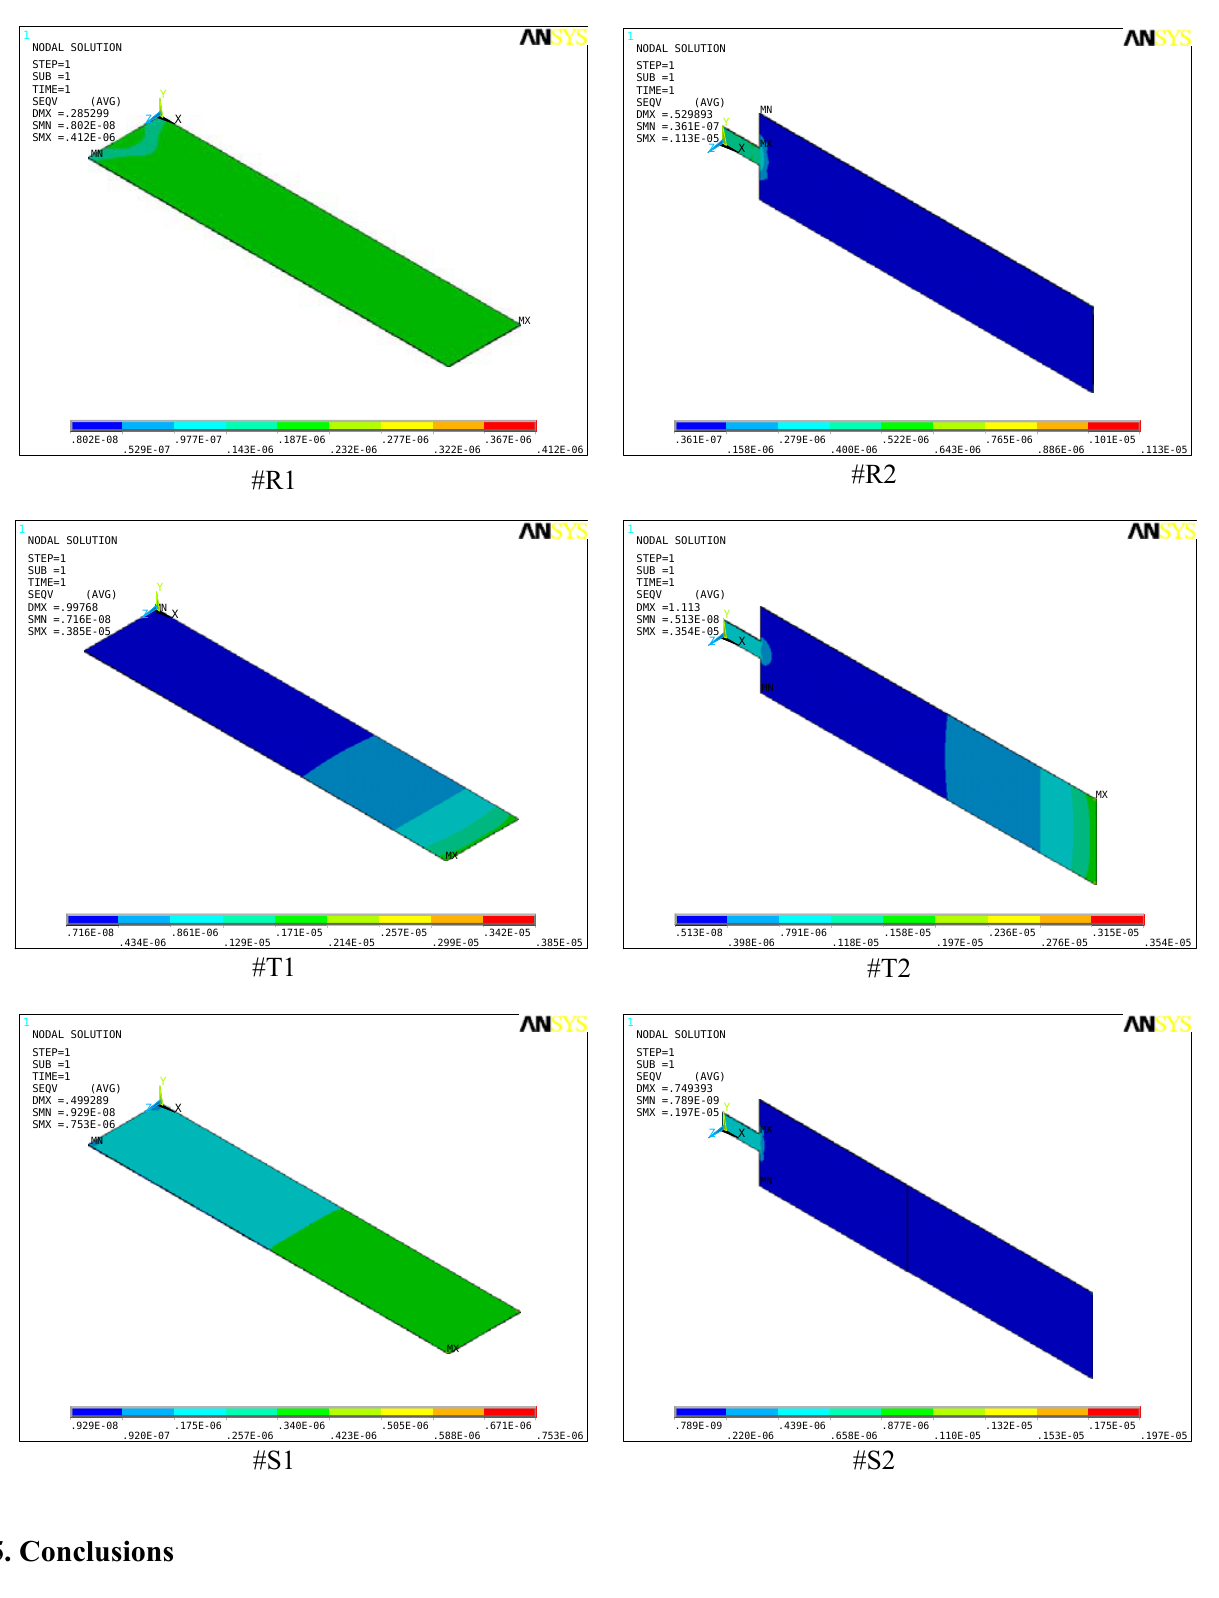
Figure 4. Stress distributions in the rectangular (#R1, #R2), triangular (#T1, #T2), and step (#S1, #S2) profile